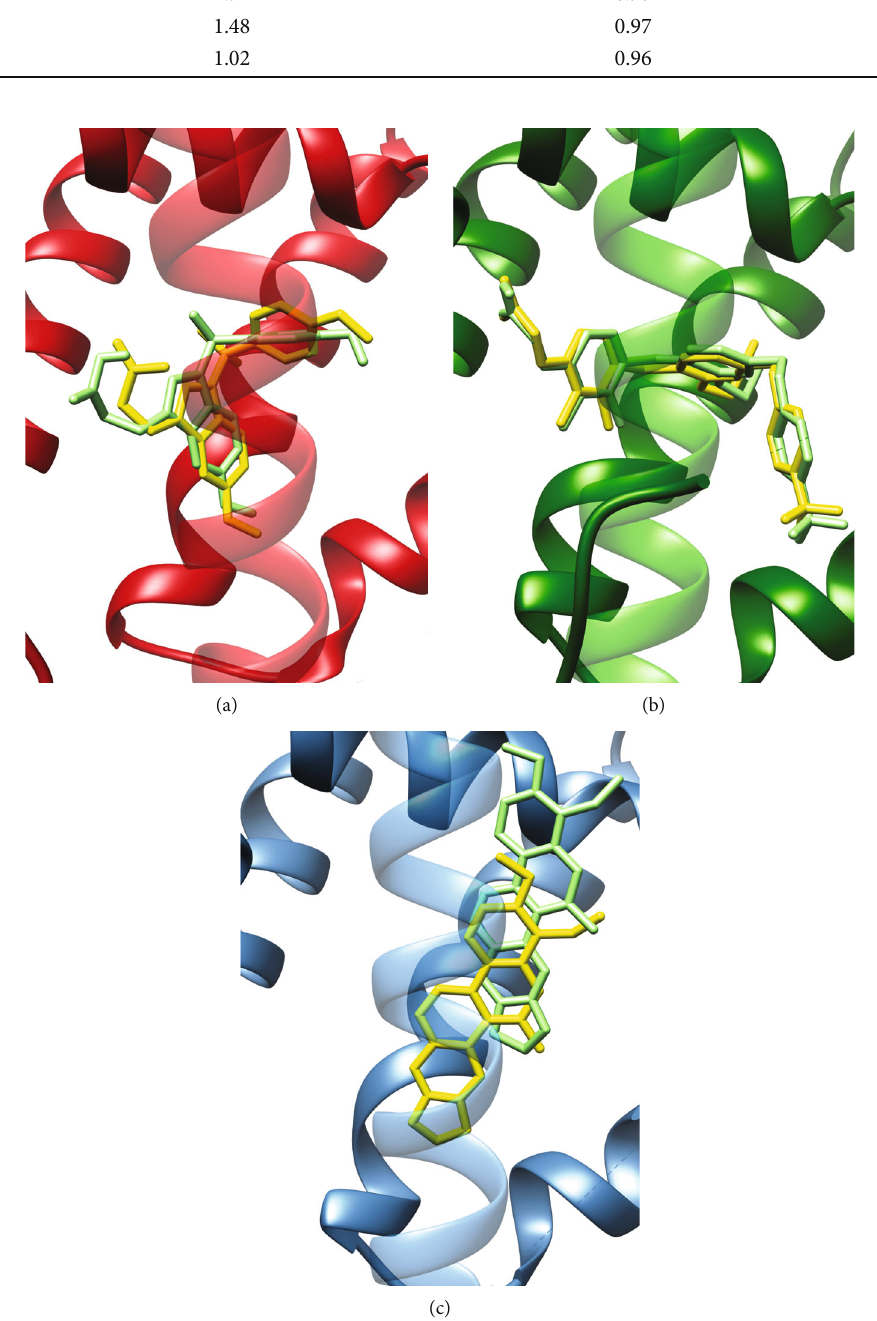
Figure 5: Results for the active molecules in the positive control group: (a) ET1 for PPAR α (in red), (b) D32 for PPAR β / δ (in green), and (c) CTI for PPAR γ (in blue). In all cases, co-crystalized ligand in yellow, blind docking prediction in green, and PPAR helix H3 transparent.